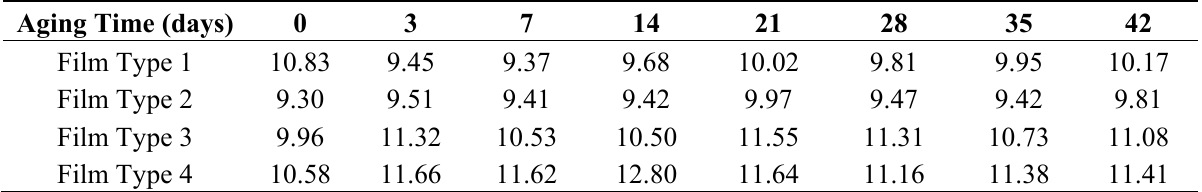
Table A2. Tensile strength (unit: ksi) vs. aging time at a 100 °C aging temperature for film Types 1–4, which have the same film thickness (5 mil), but various layer thicknesses.